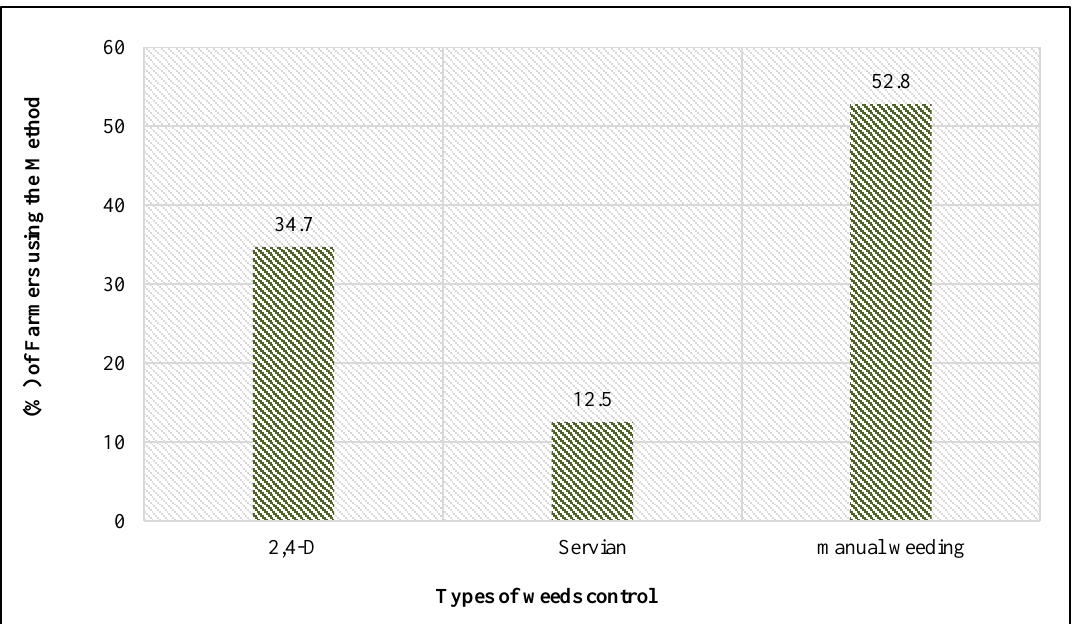
Figure 2. Weed control method used by rice farmers in Ahero irrigation